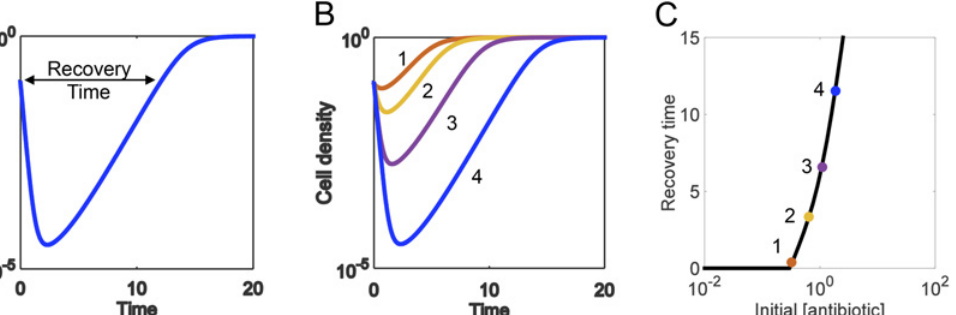
Fig 2. Defining the recovery time. (A) Recovery time defined . The recovery time is the time it takes for a population to return to its starting density after being exposed to a dose of antibiotic. (B) Each antibiotic concentration has a recovery time . To capture both the time- and concentration-dependent relationship between an antibiotic and the bacterial population, the recovery time is measured for a range of an antibiotic ’ s concentrations. (Increasing numbers labeling the curves correspond to increasing concentrations of antibiotic: 1 = weakest, 4 = strongest). (C) The recovery time curve links pathogen to an antibiotic . The recovery times for a range of antibiotic concentrations produce an informative curve that represents the interaction between a pathogen and a particular antibiotic.